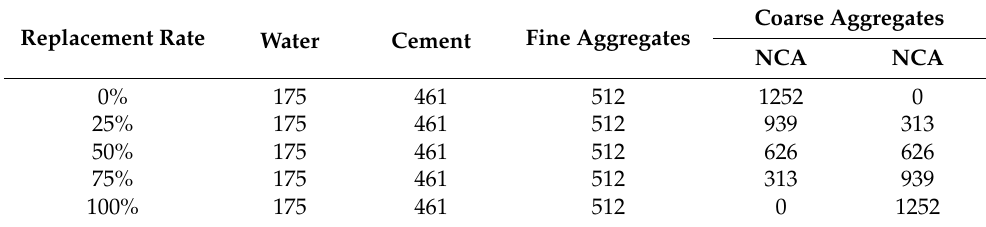
Table 1. Mix ratios of recycled concrete (unit: kg/m 3